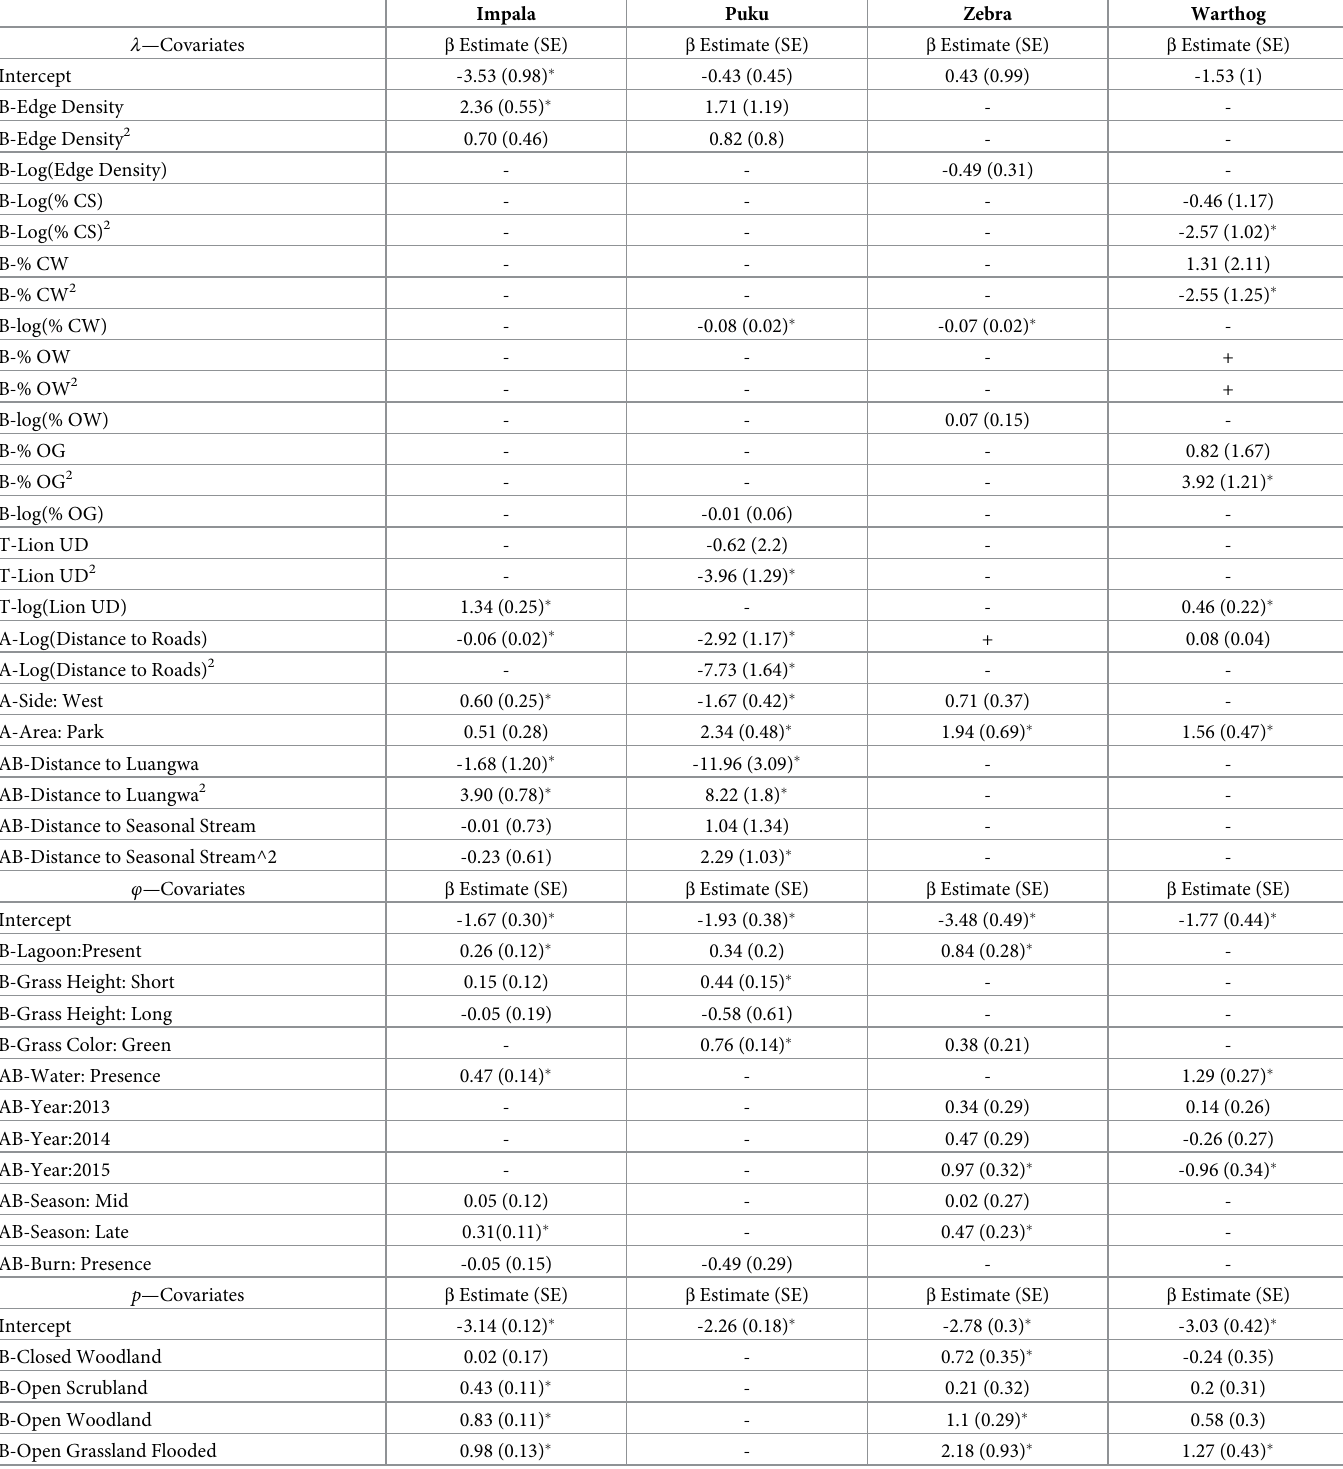
Table 4. Coefficient estimates from each species’ top group density model. Covariates included in model averaging for zebra and warthog but not in the top model are also indicated (+). Impala Puku